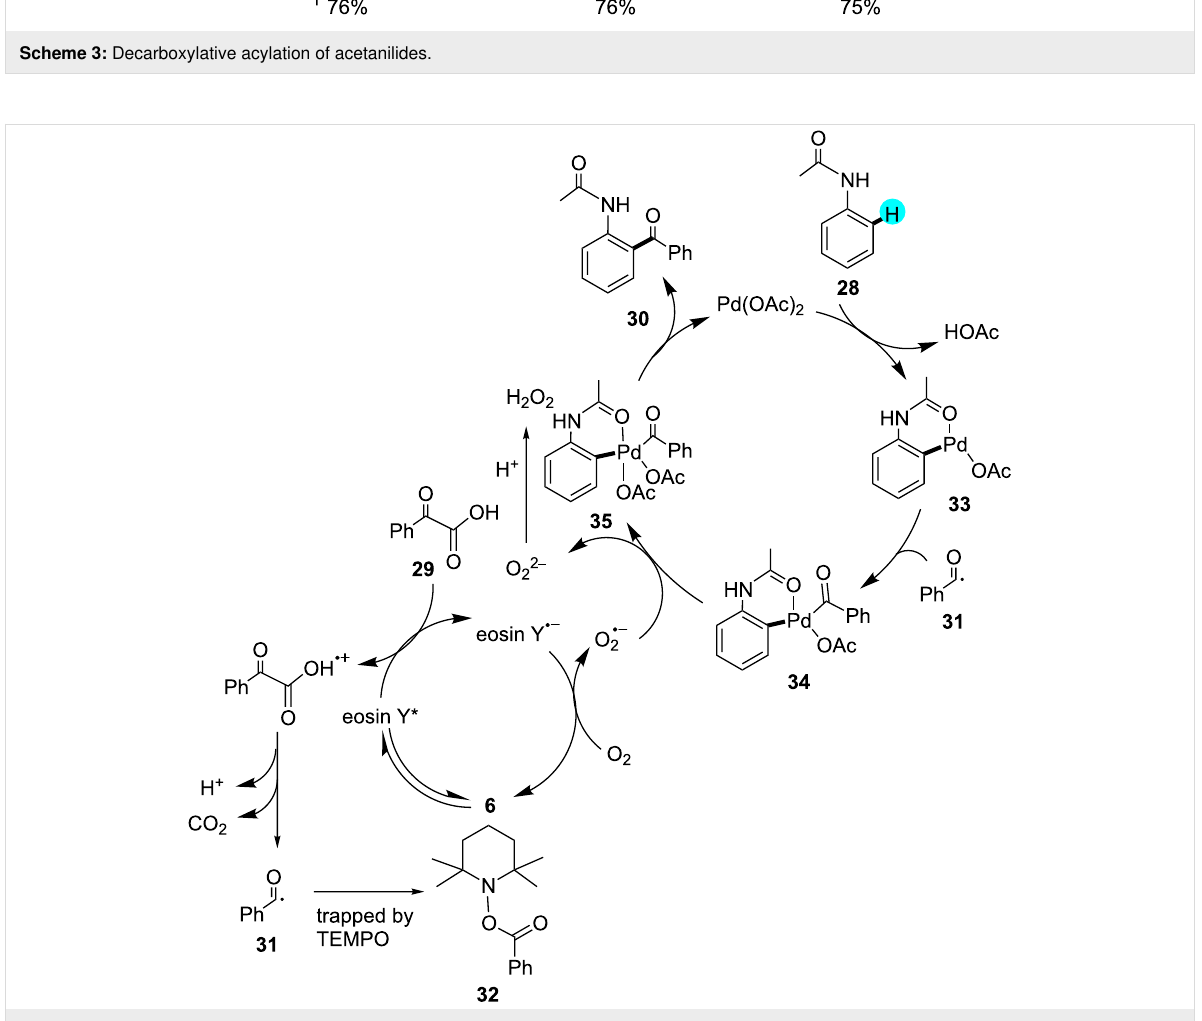
Figure 7: Mechanism for the formation of 30 from acetanilide